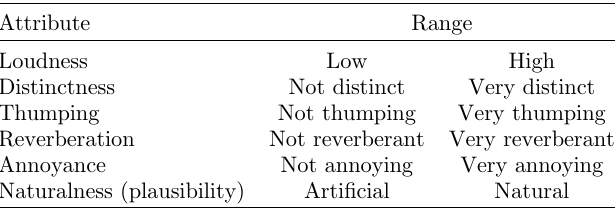
Table 3. List of attributes used in the listening test and their range.